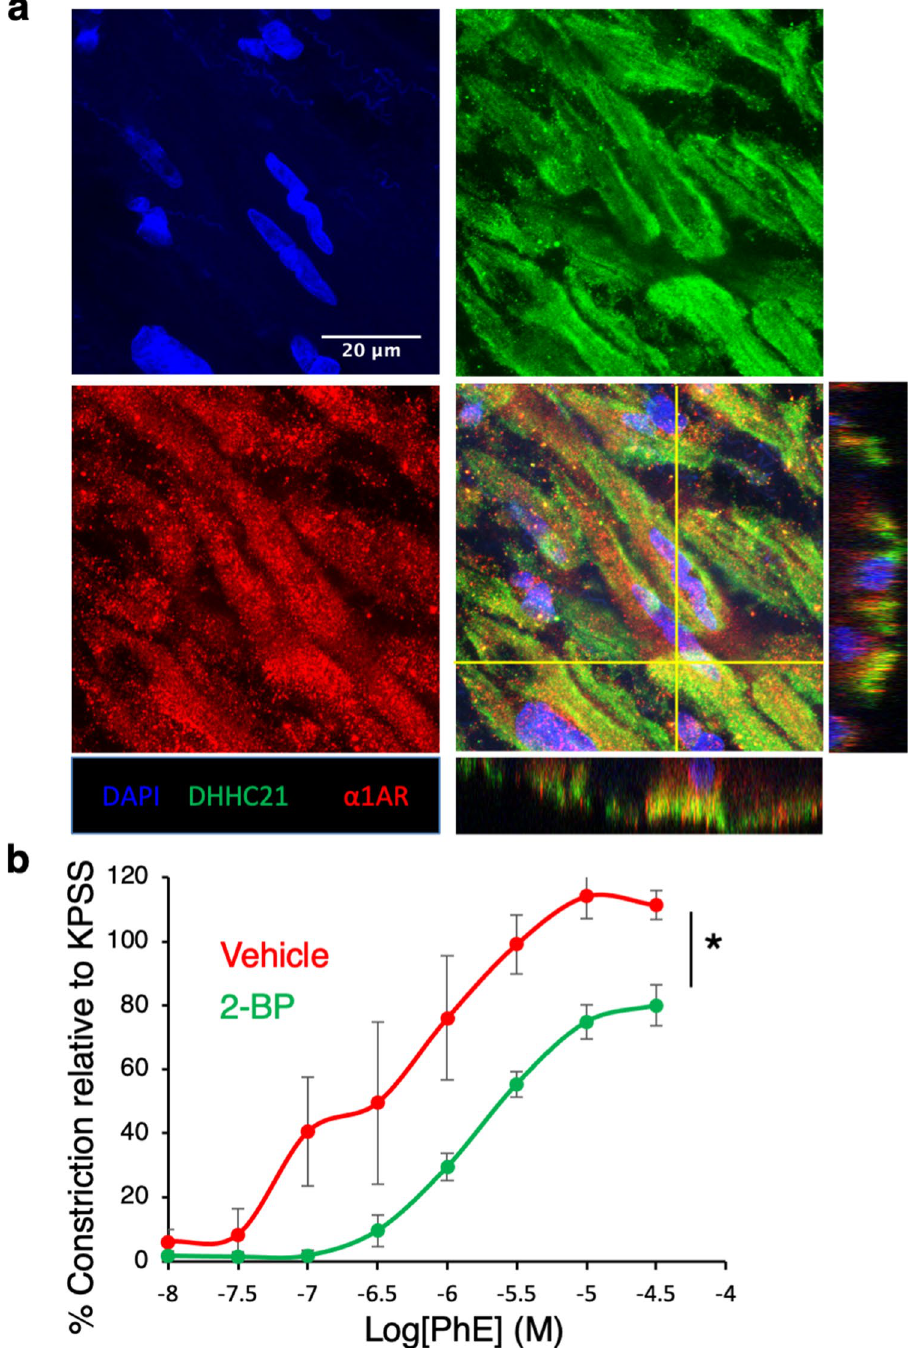
Figure 7. DHHC21 co-localizes with α1AR and palmitoylation regulates the constriction of small arteries isolated from human kidneys. ( a ) Co-localization of DHHC21 and α1AR in the cross-section of human renal arteries. Representative images of renal arteries isolated from 3 donors. ( b ) Inhibition of PATs with 2-BP results in impaired α1AR-mediated vasoconstriction in small arteries isolated from human kidneys. Vehicle control or 2-BP (100 μM) was given 1 h prior to phenylephrine challenge. Small arteries are from 3 different donors. Results represent mean ± SEM. *p ≤